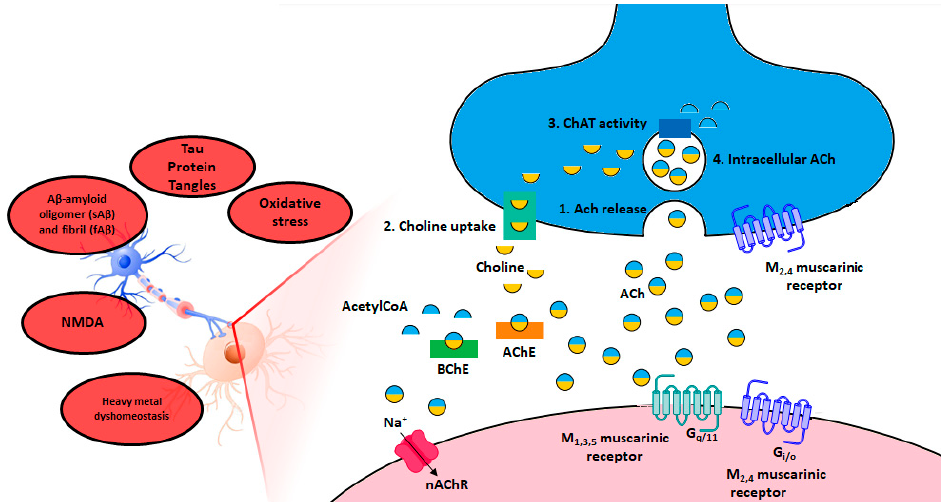
Figure 2. In the red circles some hallmarks of Alzheimer's disease are reported, the cholinergic hypothesis is emphasized through the schematic representation of a pre and postsynaptic neuron. Zoom in on the cholinergic synapse in particular biosynthesis, storage, release, hydrolysis of ACh and AChR locations are illustrated (modified from Auld et al. [24]).